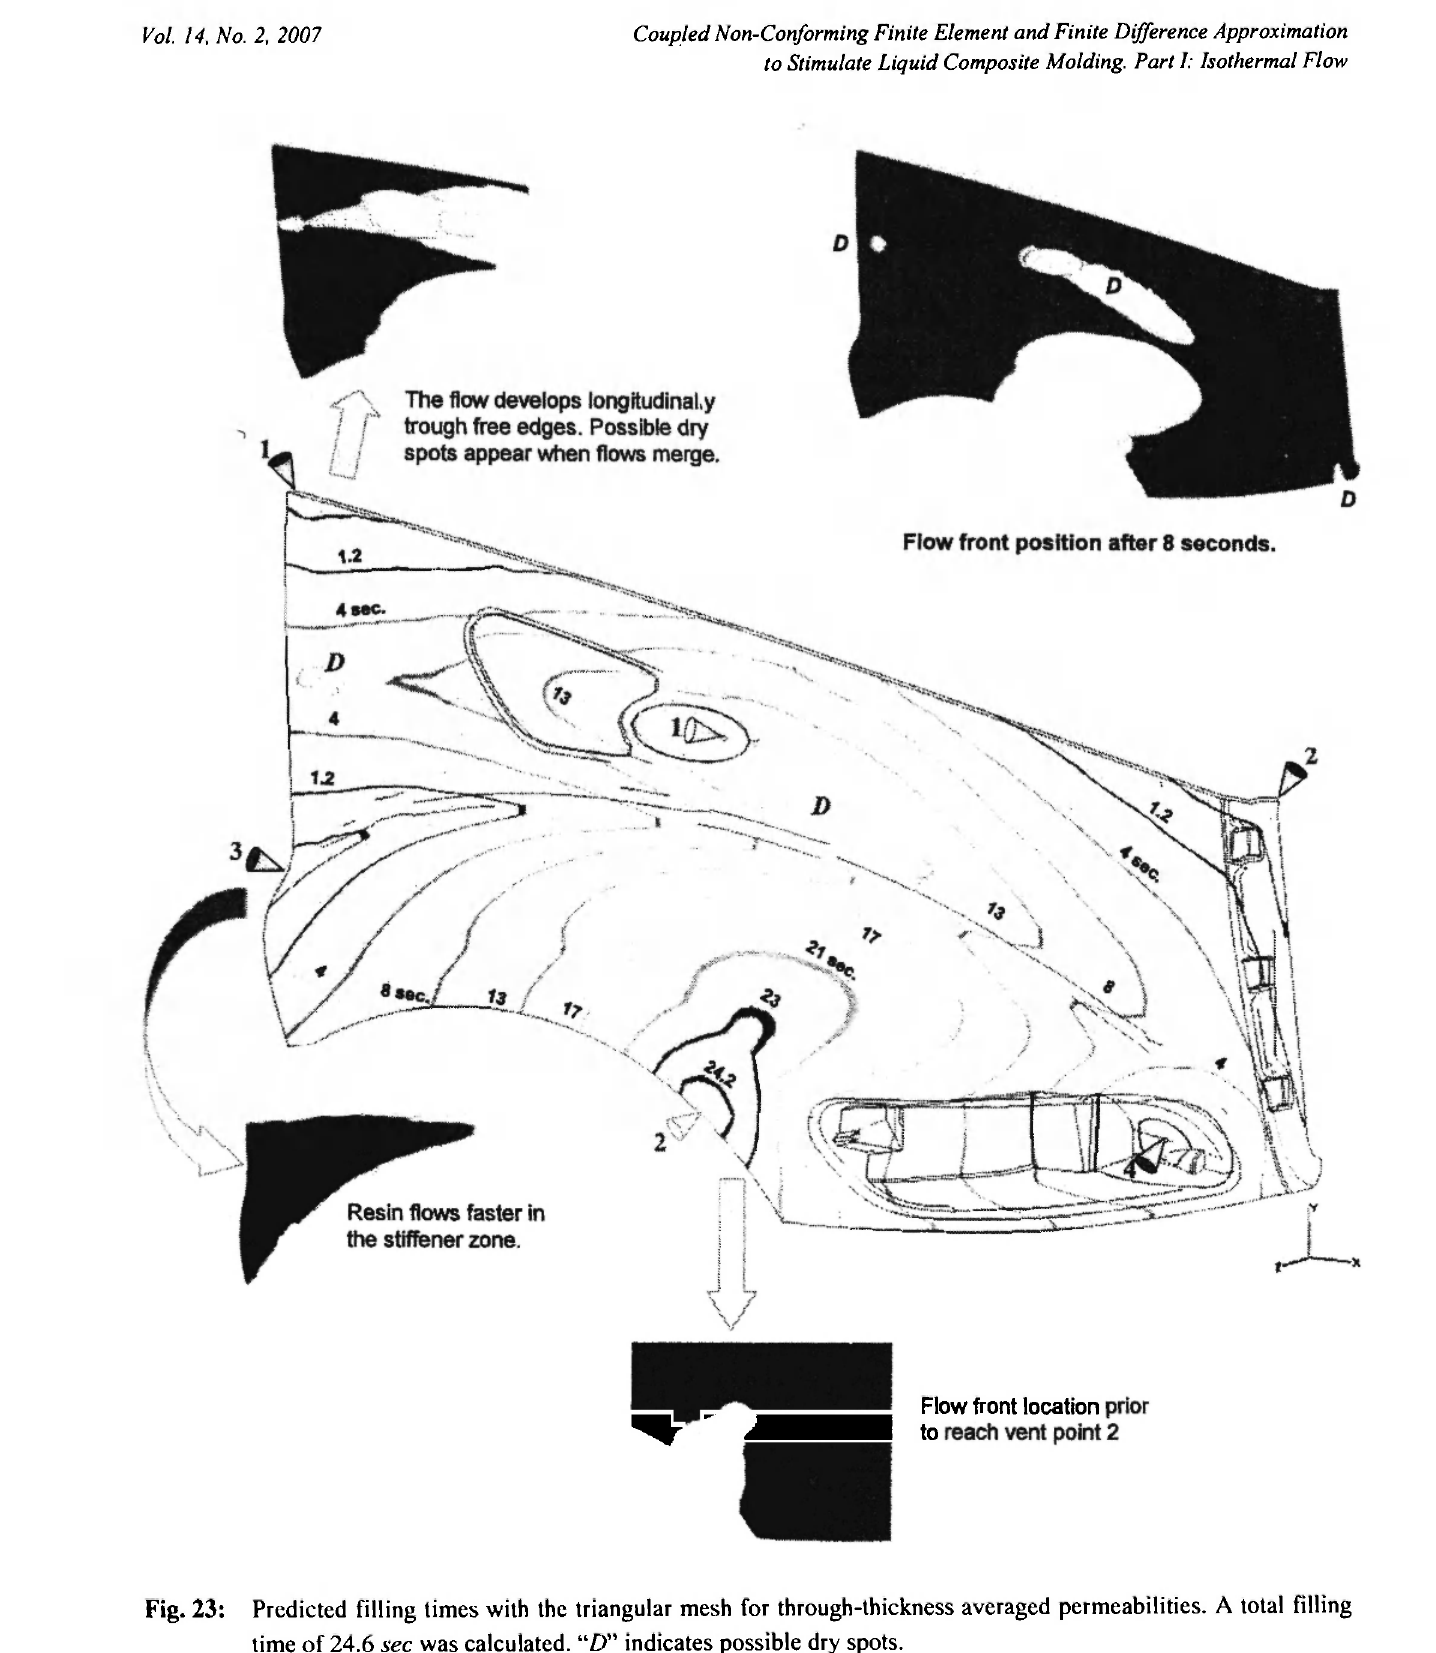
Fig. 23: Predicted filling times with the triangular mesh for through-thickness averaged permeabilities. A total filling time of 24.6 sec was calculated. "£>" indicates possible dry